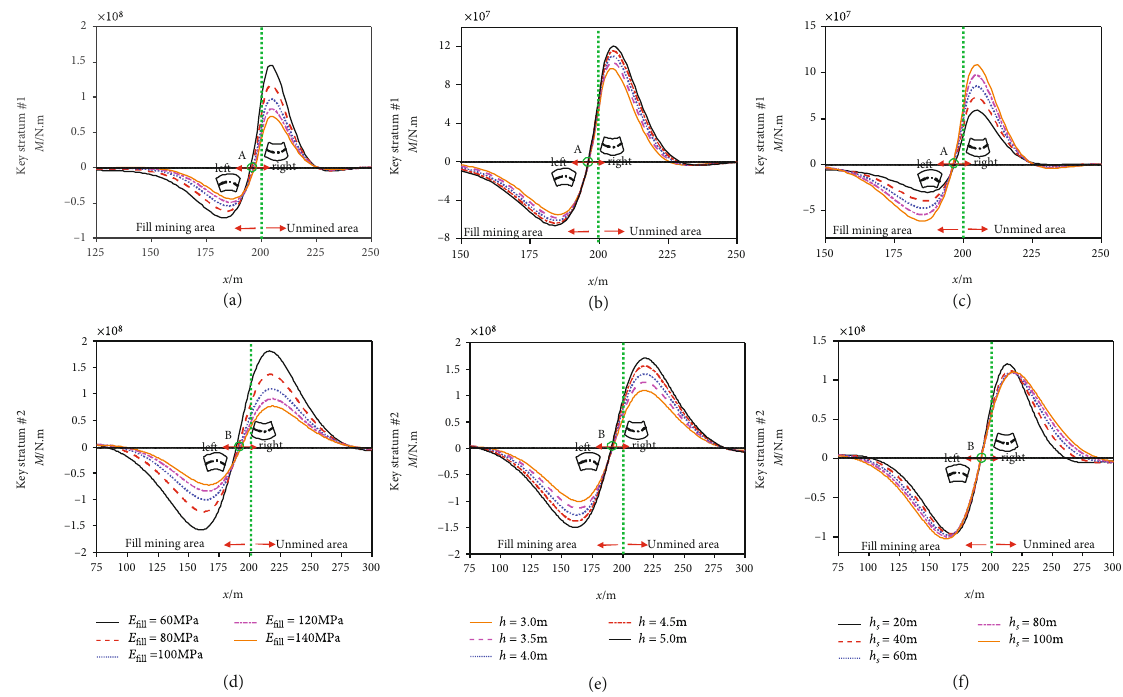
Figure 7: The bending moment curves of key strata with the distance to the middle of the stope under various (a, d) elastic modulus of back fi ll, (b, e) mining height, and (c, f) thickness of soft layers.